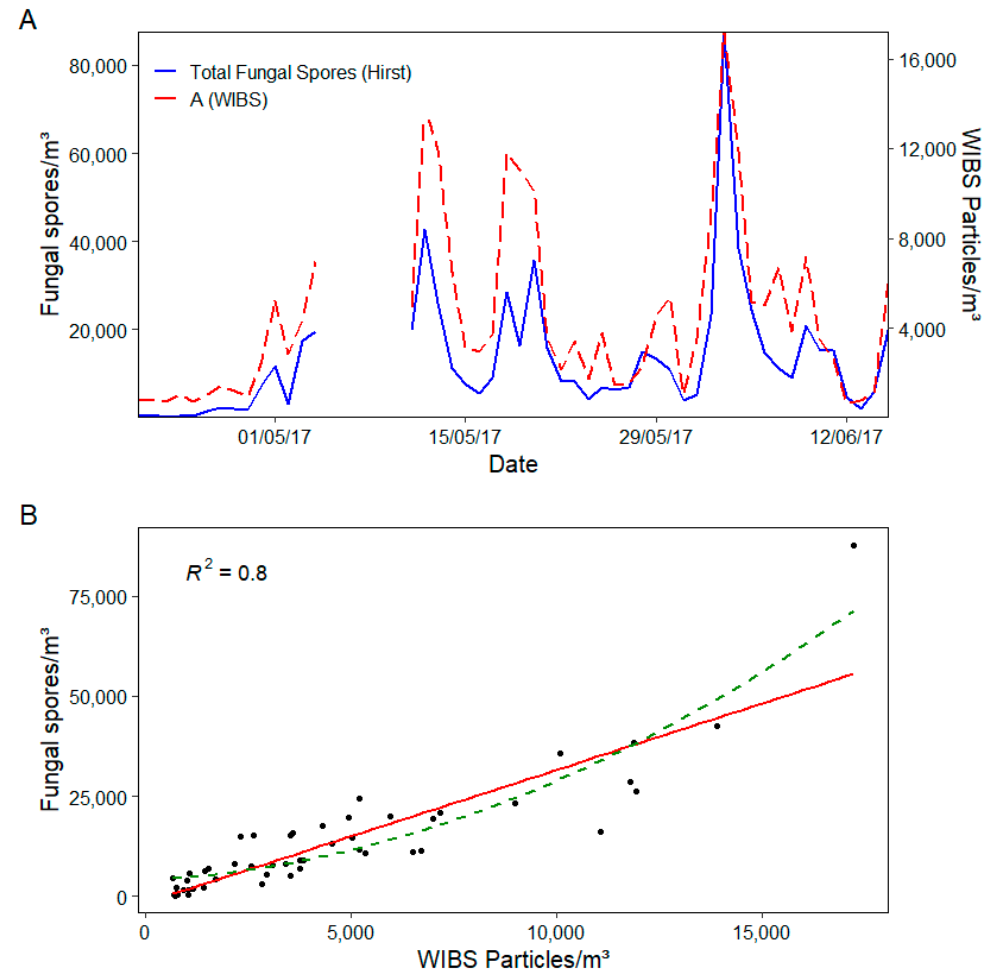
Figure 6. ( A ) Daily time series of Hirst fungal spore vs. WIBS A (9 σ ) particle concentrations and ( B ) scatter plot of the relationship between daily Hirst fungal spore and WIBS A particle concentrations (depicted as black dots), where the red line represents a linear regression, and the green line represents a polynomial regression.